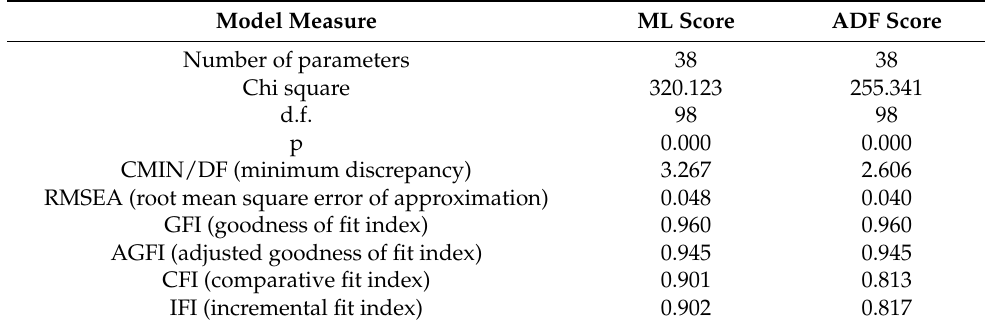
Table 4. Characteristics and goodness-of-fit statistics for the four-factor model of ADS